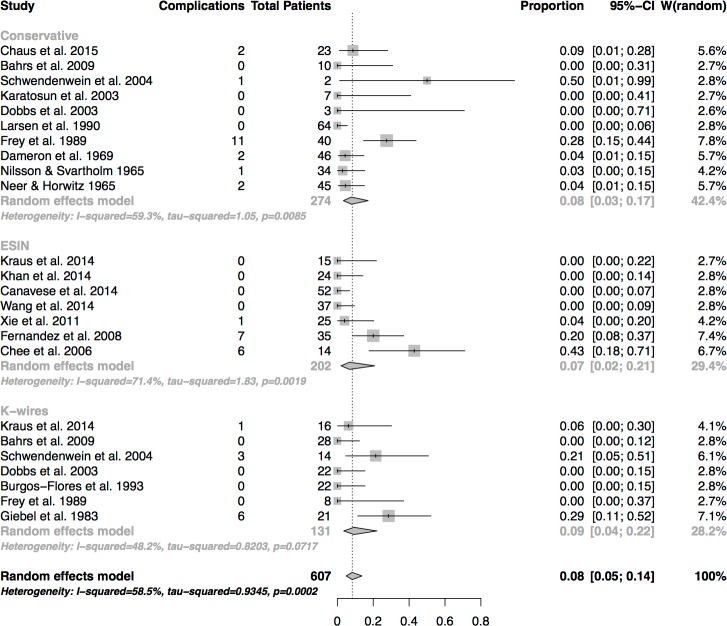
Analysis of complications.Registration of complications occurring during the healing process.